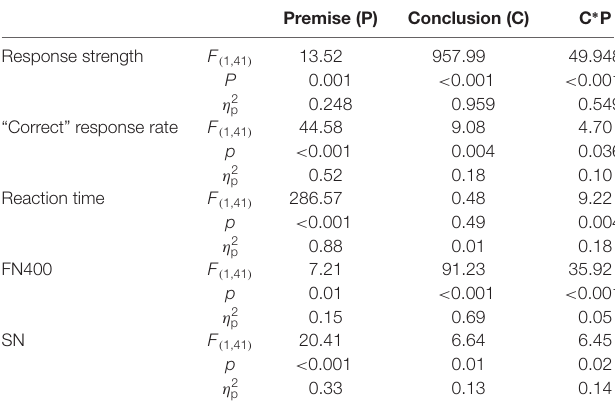
TABLE 1 | Results of the two-way repeated-measures ANOVAs of the response strength, “correct” response rate, reaction times, FN400 amplitudes and sustained negativity (SN) amplitudes in anterior